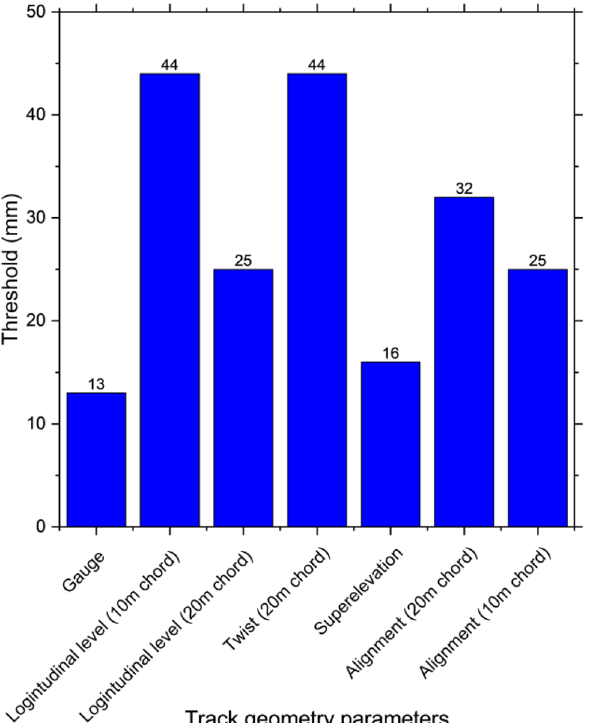
Figure 2. Threshold of each track geometry parameter.